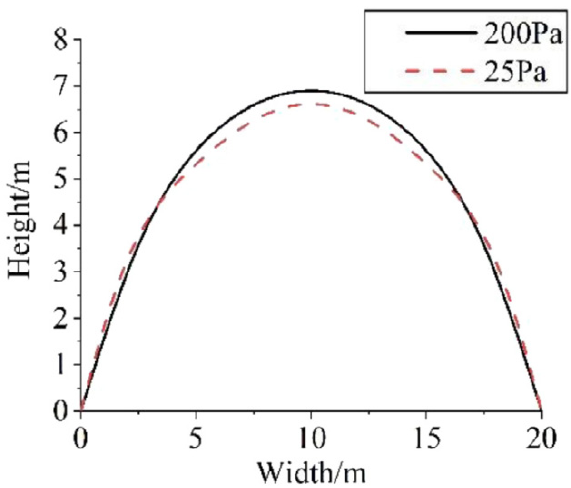
Figure 21. The early stage of deflation structural profile